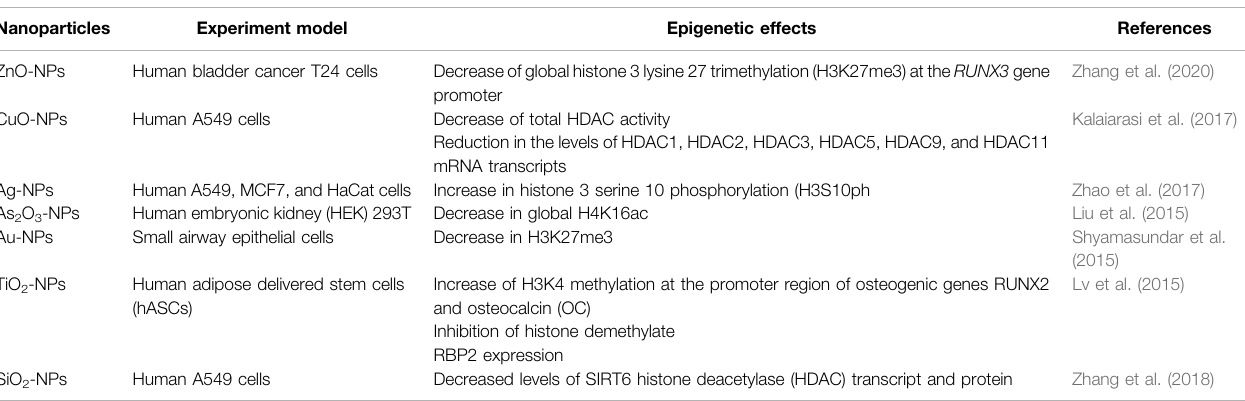
TABLE 4 | In vitro and in vivo studies on the impact of nanoparticles on histone modi fi cation.